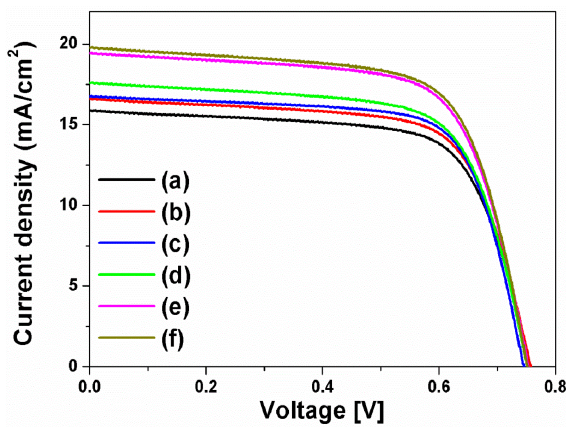
Figure 4. Current density-voltage curves of DSSCs based on a layer-by-layer structure: ( a ) without metal NPs, ( b ) with spherical Ag NPs, ( c ) with multi-shaped Ag NPs, ( d ) with Au NPs, ( e ) with spherical Ag and Au NPs, and ( f ) with multi-shaped Ag and Au NPs. Table 1. Photovoltaic properties of DSSCs based on a layer-by-layer structure. I-V